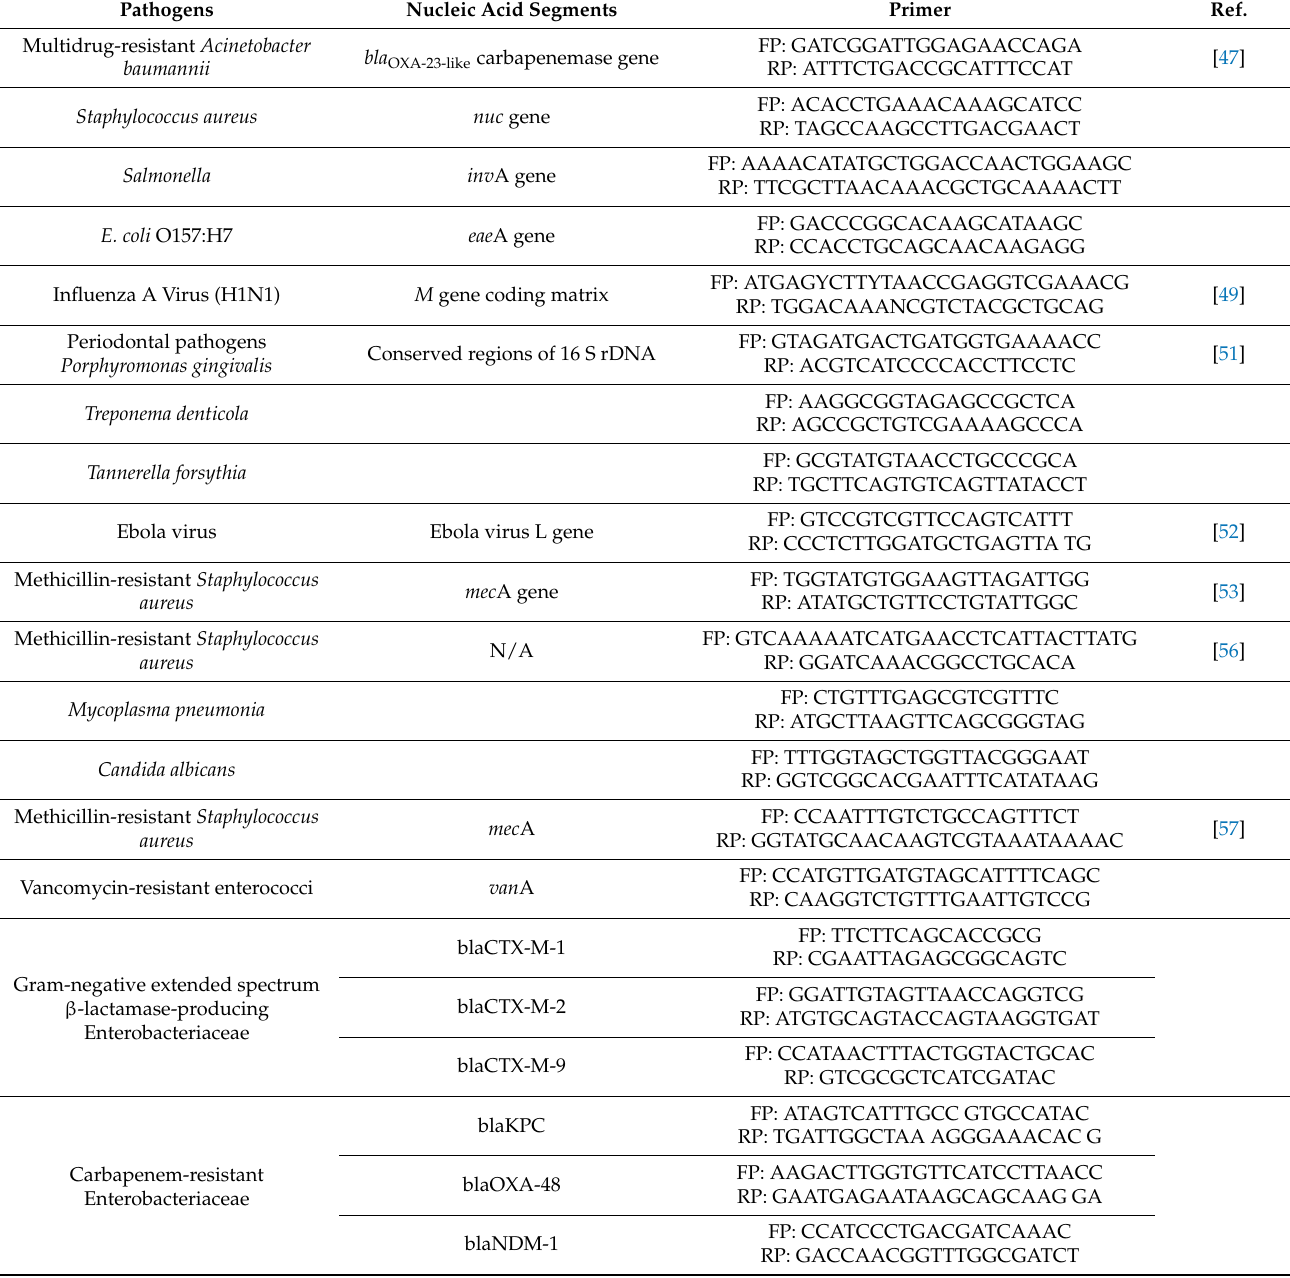
Table 1. Target genes and primers used for pathogen